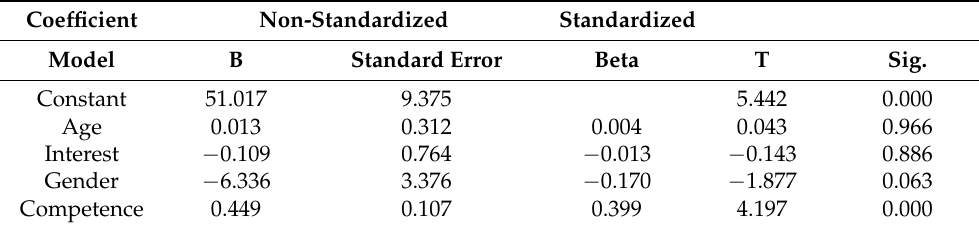
Table 5. Adjustment of the variables analysed to the predictor model. Coefficient Non-Standardized Standardized Model B Standard Error Beta Constant